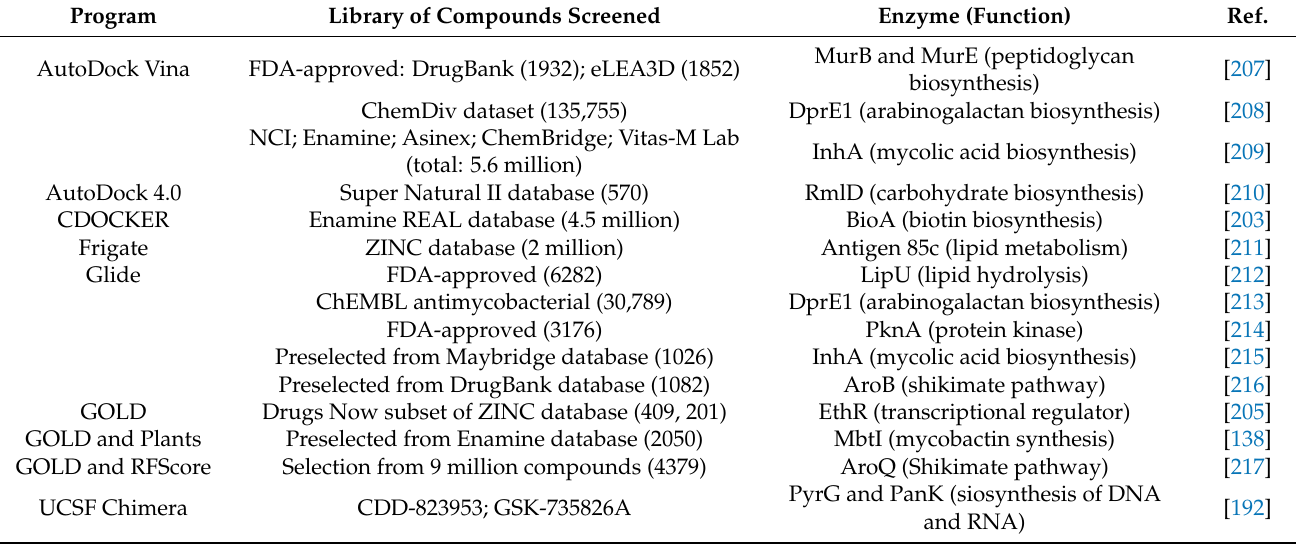
Table 8. Studies involving SBVS molecular-docking approaches against Mtb